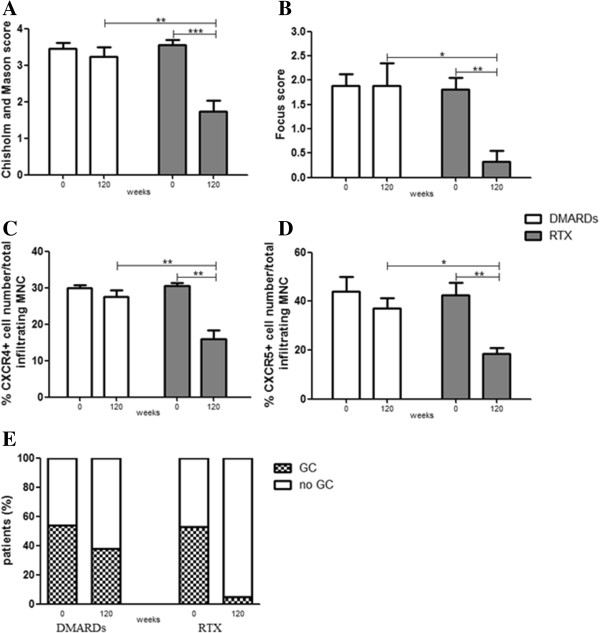
Histological assessment of minor salivary gland biopsies. (A), (B) Histological scoring of minor salivary gland (MSG) biopsies in the rituximab (RTX) and disease-modifying anti-rheumatic drug (DMARD) treatment groups at baseline and week 120. (C), (D) Percentage of CXCR4-positive cells and CXCR5-positive cells inside the glandular infiltrate. Bars indicate mean ± standard error of the mean. ***P <0.001, **P <0.01 and *P <0.05. (E) Percentage of patients displaying germinal centers (GCs) in the RTX and DMARD treatment groups at baseline and week 120. MNC, mononuclear cells.